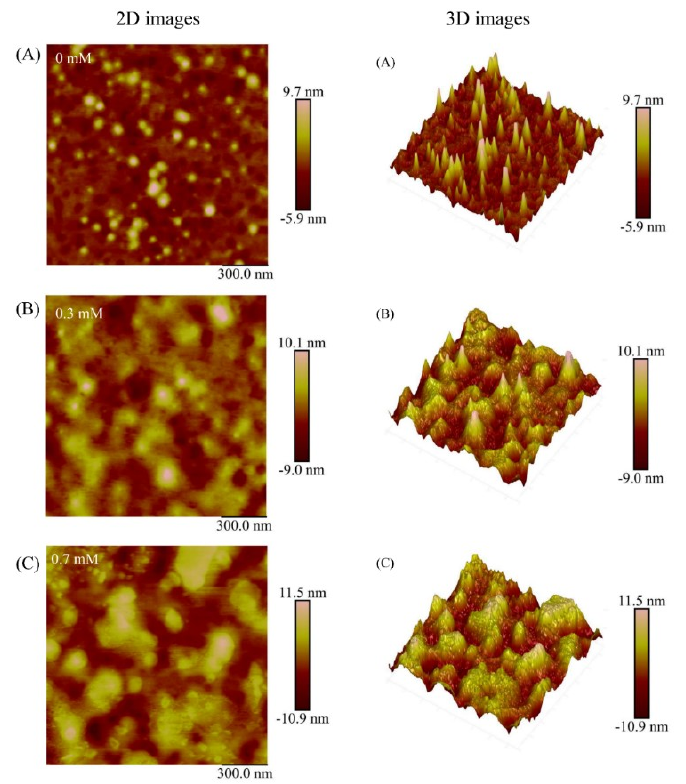
Figure 4. Effect of MDA on the morphology of MP. The 0 mM MDA treated sample ( A ), 0.3 mM MDA treated sample ( B ), 0.7 mM MDA treated sample ( C ). The scan size is 1.5 µ m × 1.5 µ m.